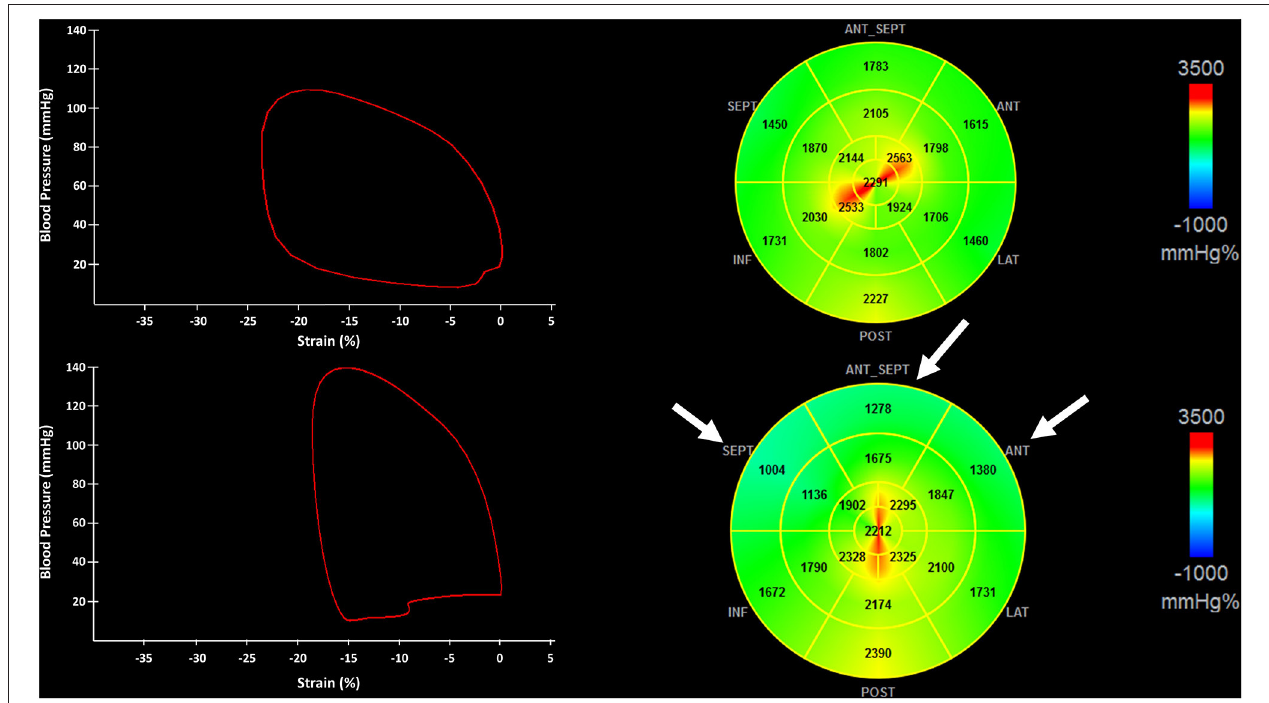
FIGURE 2 | The figure shows pressure-strain loops (Left) and the bullseye of the regional distribution of non-invasive myocardial work index (Right) from a patient with no critical coronary stenosis (CAST) (Upper) and CAST of the left anterior descendent artery (LAD) (Lower). Myocardial segments underlying the LAD stenosis are indicated by white arrows. CAST, critical coronary stenosis; LAD, left anterior descending